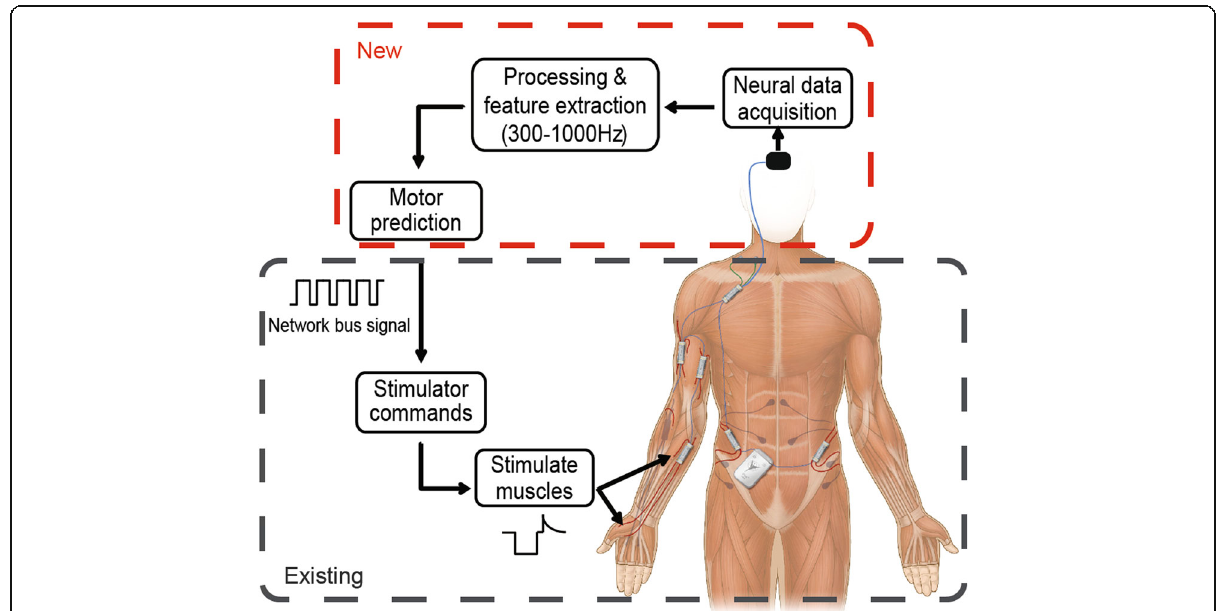
Fig. 1 Concept diagram for brain-controlled FES. The grey box denotes the existing NNP system and the red box denotes the planned novel module